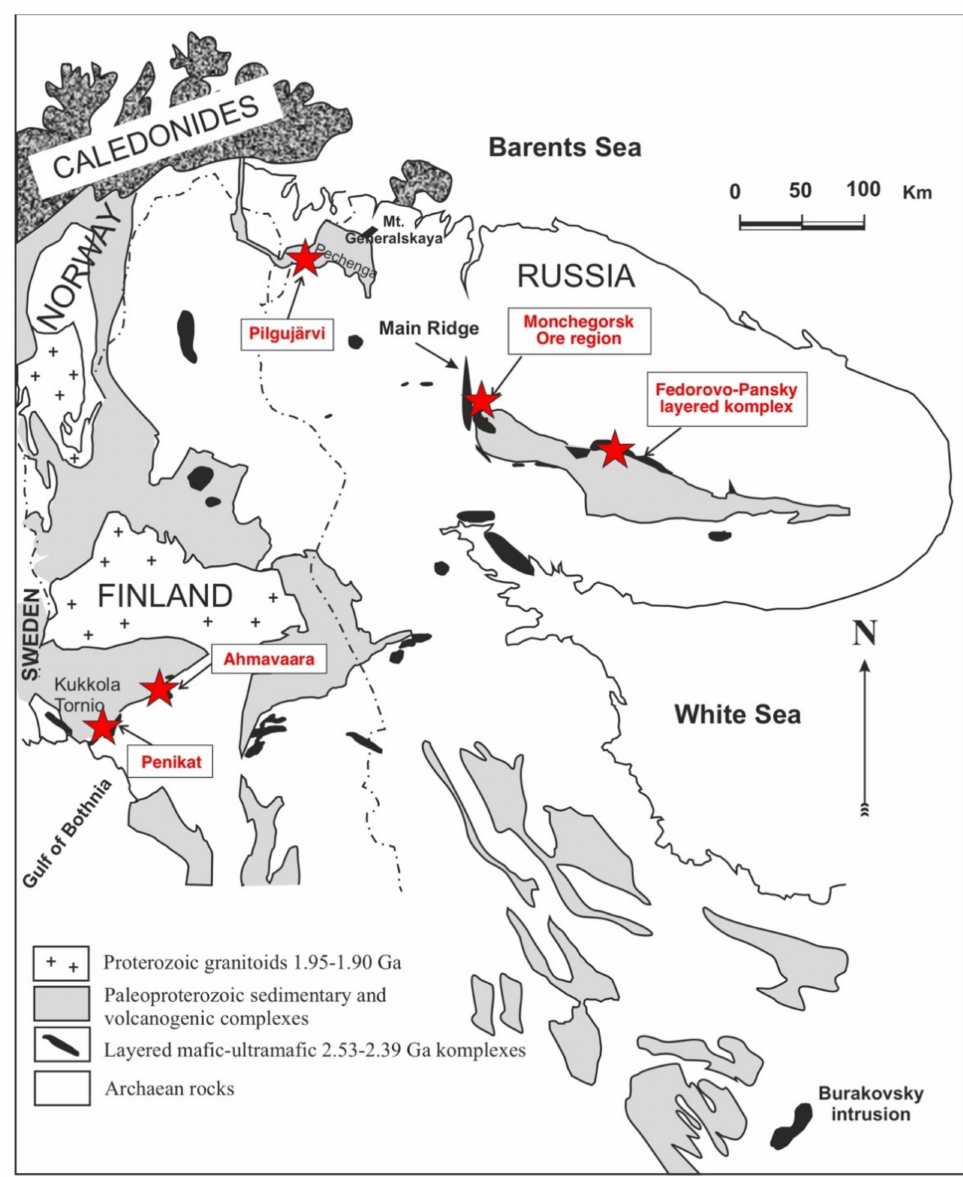
Figure 1. Generalized geological map of the northeastern part of the Baltic Shield and the location of Paleoproterozoic mafic layered intrusions (modified after [3]). Red asterisks indicate sampling